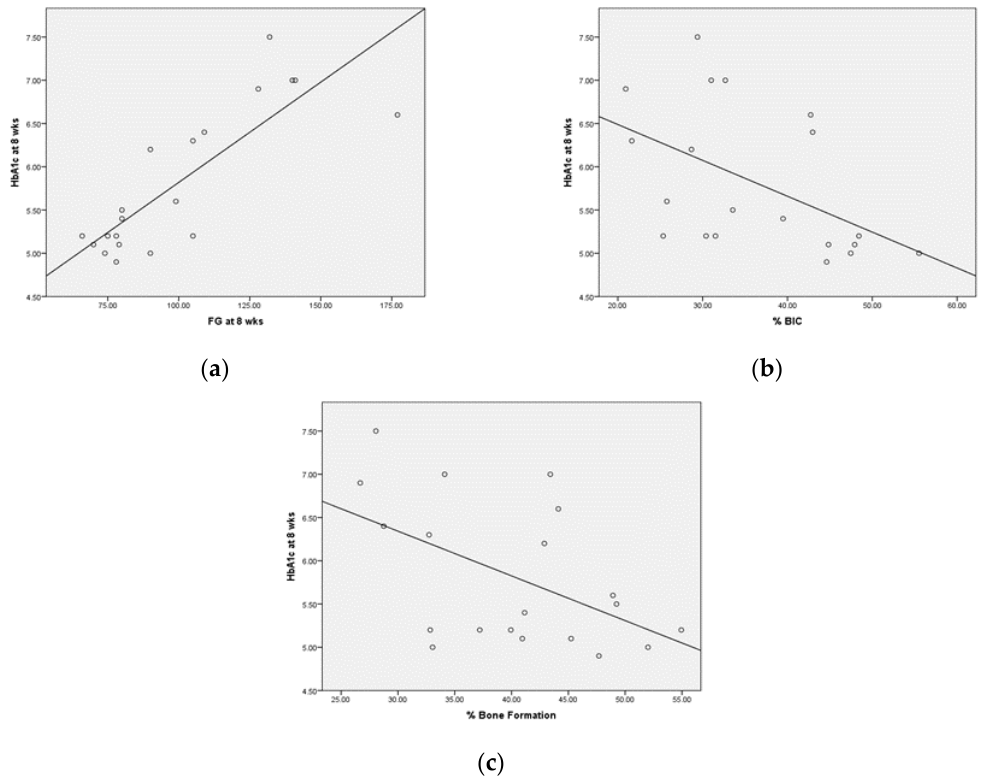
Figure 7. Correlation between fasting glucose (FG) and HbA1c ( a ), HbA1c and %BIC ( b ), HbA1c and % bone formation ( c ). There was a strong correlation between increased HbA1c and decreased BIC ( p < 0.05) and decreased new bone formation ( p <